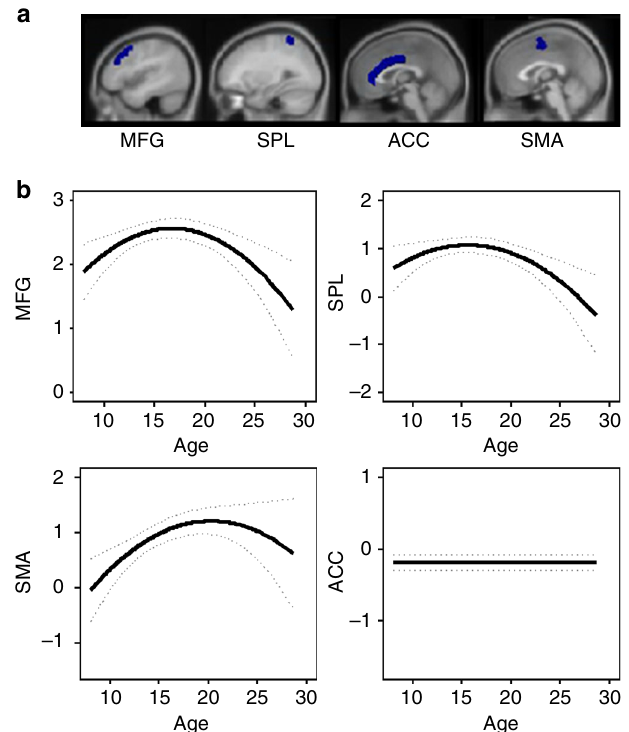
Fig. 4 Mixed-model analyses for development of cortical regions in the frontoparietal network. a Anatomical ROIs (Harvard-Oxford Cortical Atlas). Center-of-mass coordinates were ( x , y , z ): middle frontal gyrus (MFG) ( − 4, 22, 43); superior parietal lobule (SPL) (7, − 48, 63); supplementary motor area (SMA) (0, − 2, 58); anterior cingulate cortex (ACC) (1, 20, 24). b Predicted developmental trajectories for sensitivity to learning signals. A quadratic age effect was the best fi t for MFG (no age: AIC = 2649;